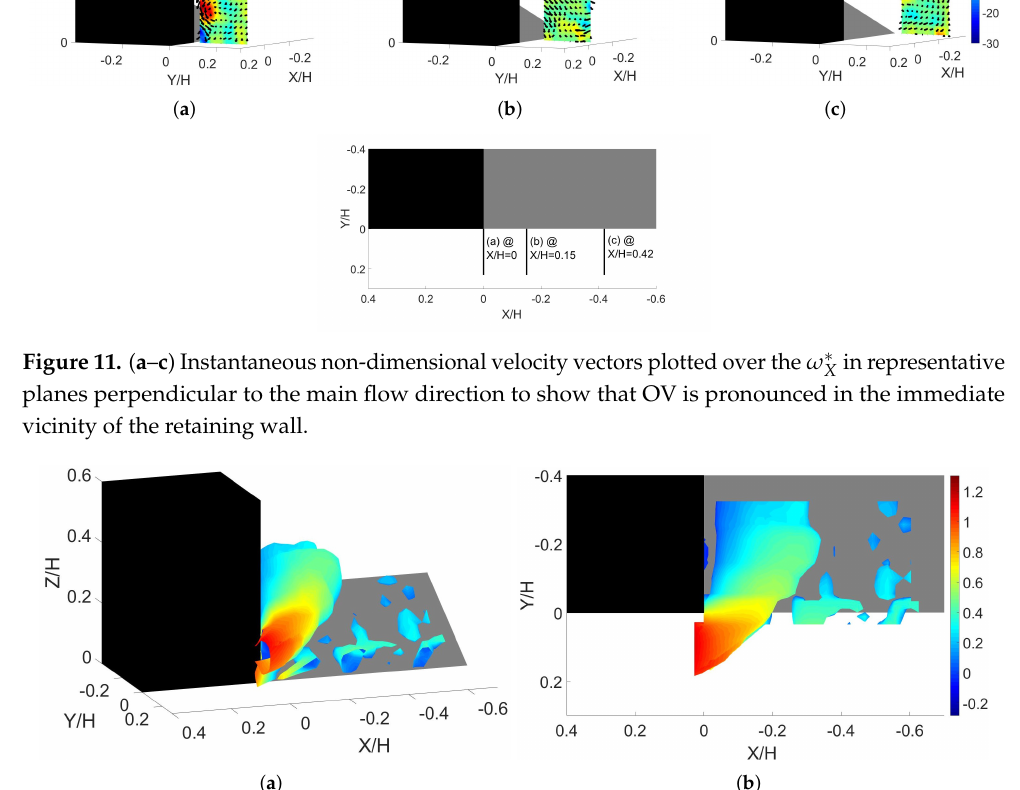
Figure 12. Visualization of the mean flow using Q-criterion. ( a ) shows a 3D view, and ( b ) illustrates a plan view for the same levels of iso value